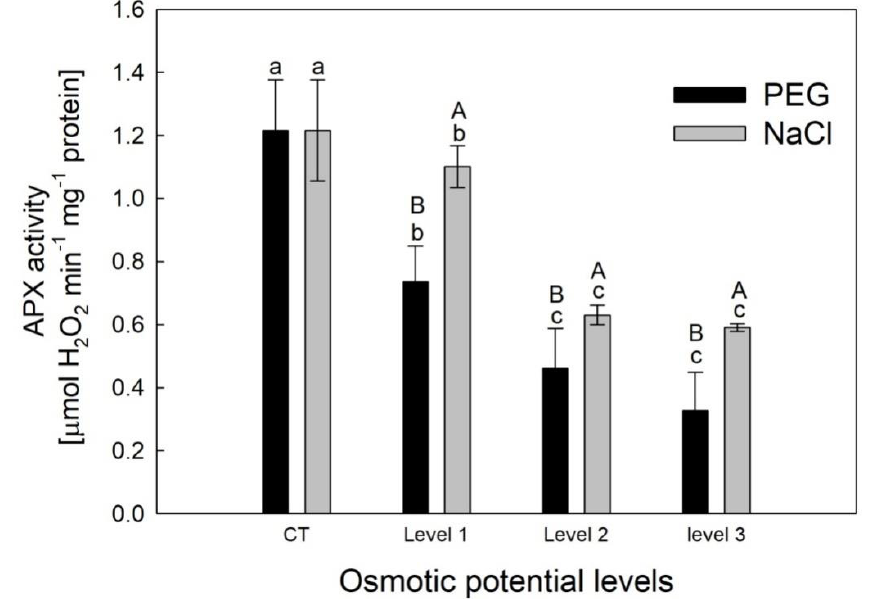
Figure 4. Means ± SD (n = 3) of ascorbate peroxidase (APX) activity of leaves collected from seedlings grown under three iso-osmotic potential levels under separate PEG and NaCl treatments. Level 1: 24% (w/v) PEG and 200 mM NaCl; Level 2: 26.5% (w/v) PEG and 250 mM NaCl; Level 3: 29% (w/v) PEG and 300 mM NaCl. Means with different lowercase letters significantly differ in an LSD test under different PEG or NaCl concentrations, respectively ( p < 0.05). Means with different capital letters significantly differ in a t -test between PEG and NaCl concentration at the same osmotic potential level.